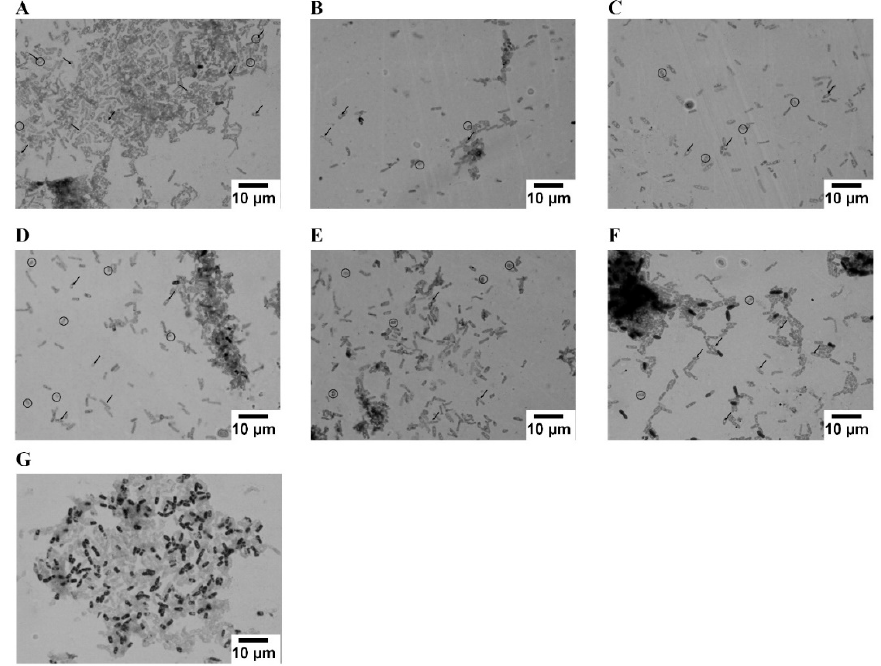
Figure 2. Morphogenesis of B. cereus when exposed to 20 mg/L of ( A ) La, ( B ) Ce, ( C ) Y, ( D ) Pr, ( E ) Tb, ( F ) Eu and ( G ) all REE tested. Light-grey-cells—Gram-negative stained cells; Black-cells—Gram positive stained cells. → spores; Ο —Oval-shaped cells. Objective magnification: 100 X